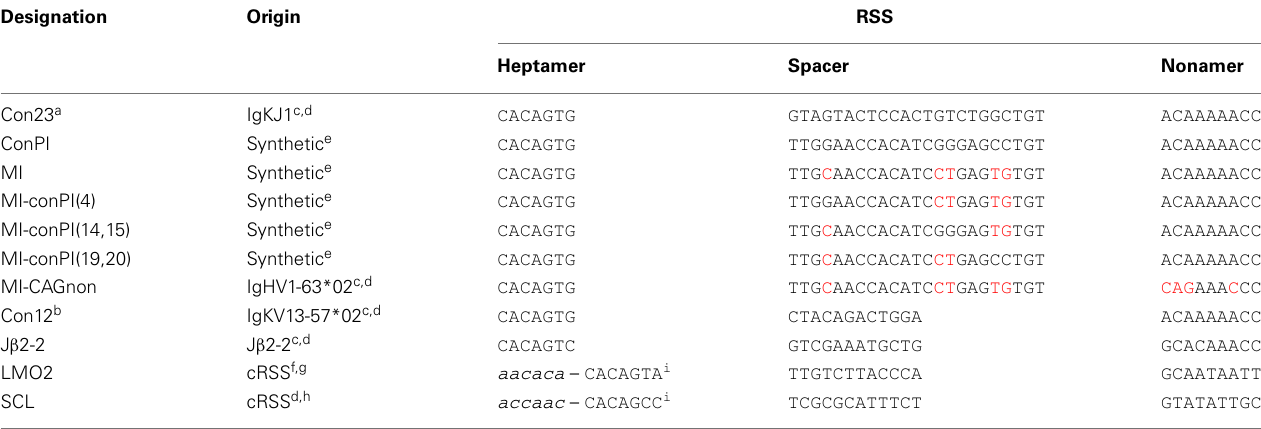
Table 1 | RSSs tested with the GFPi-mRFP